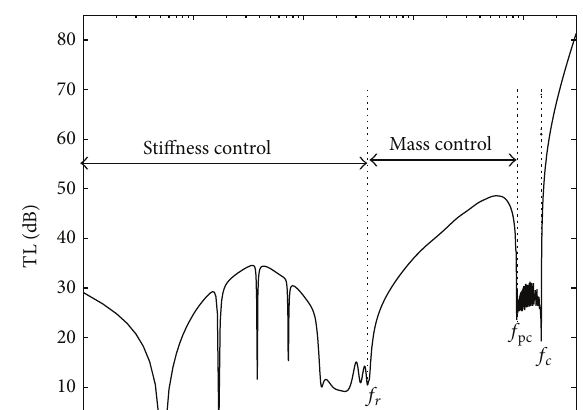
Figure 2: The TL of FGM shell.